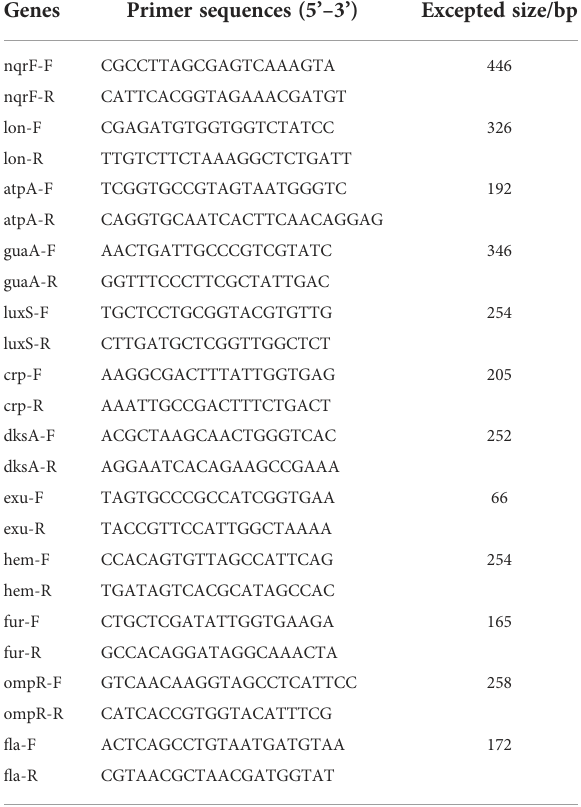
TABLE 1 Primers for virulence gene